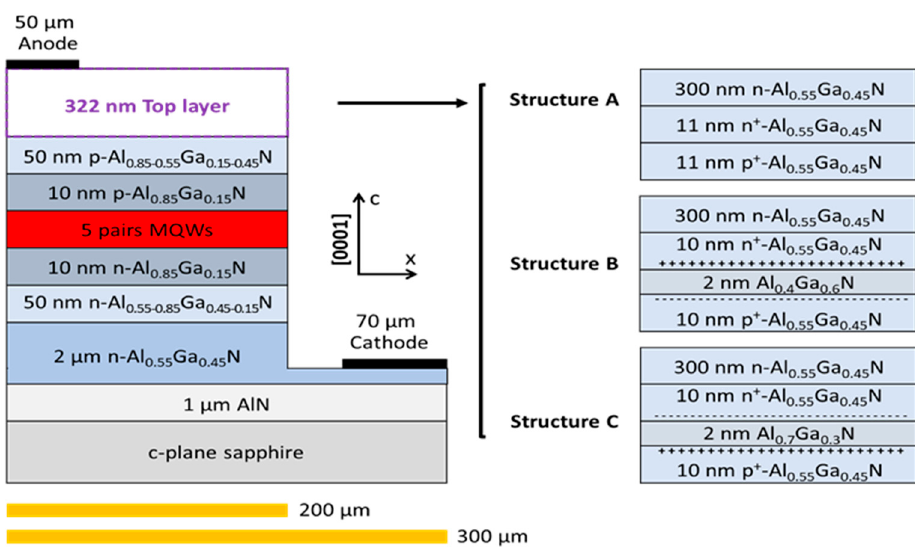
Figure 1. LED structures and the different top layers of Structures A, B, and